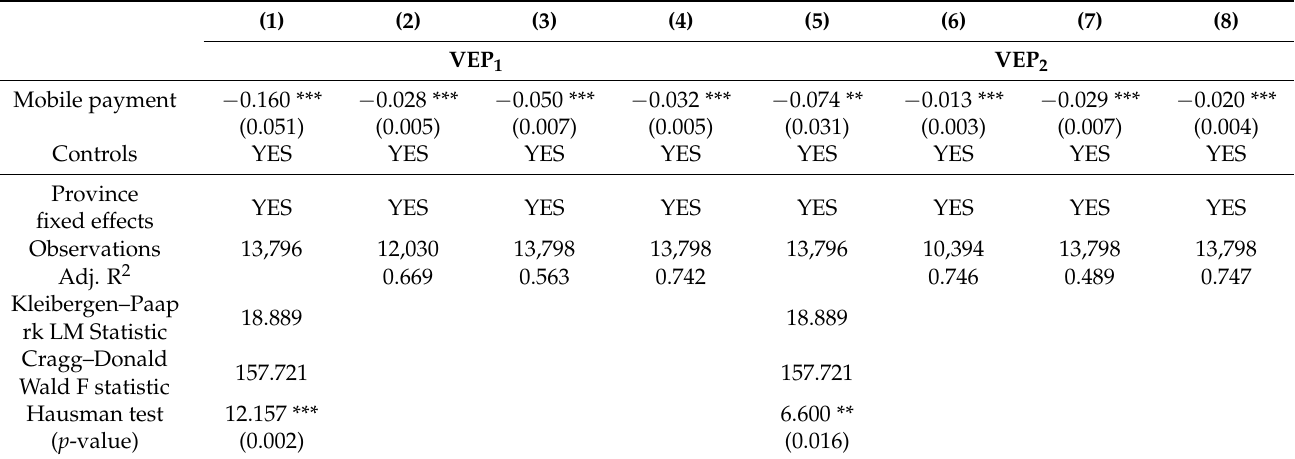
Table 5. Mobile payment on household poverty vulnerability: robustness